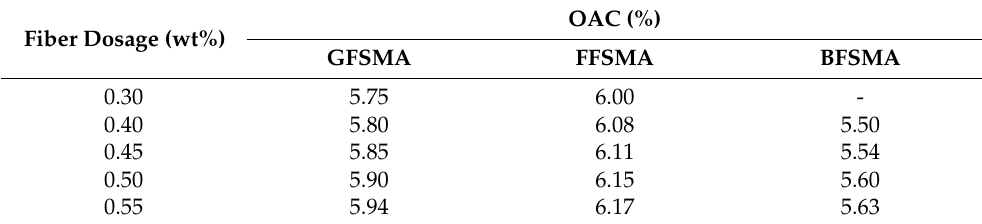
Table 5. Result of